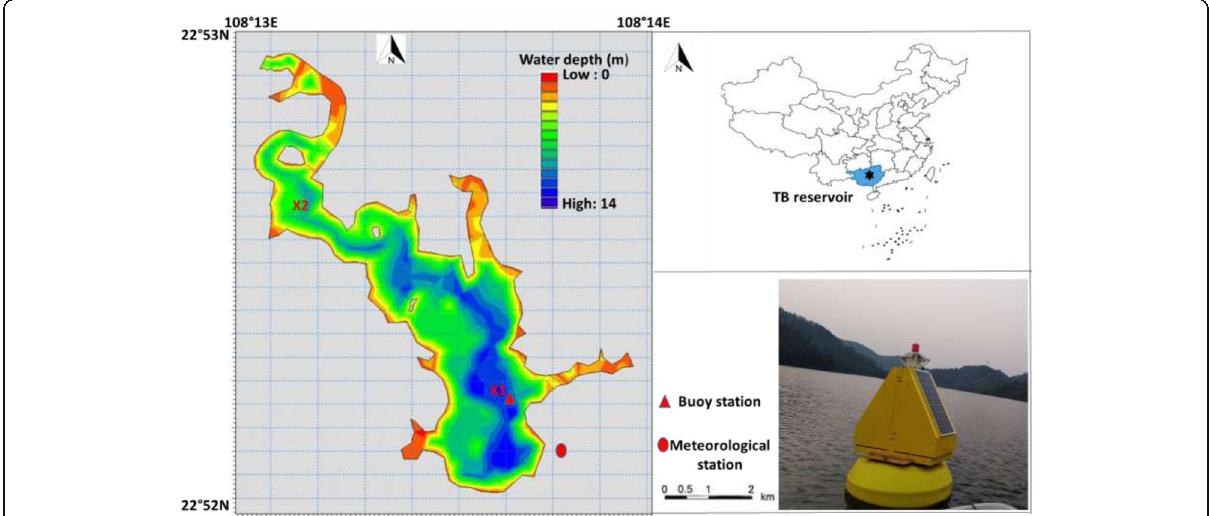
Fig. 1 Location of the study area (Tianbao